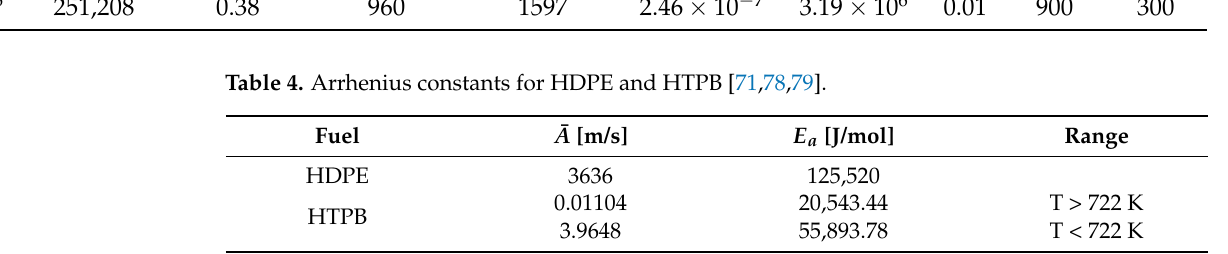
Table 5. Formation enthalpies ∆ h ◦